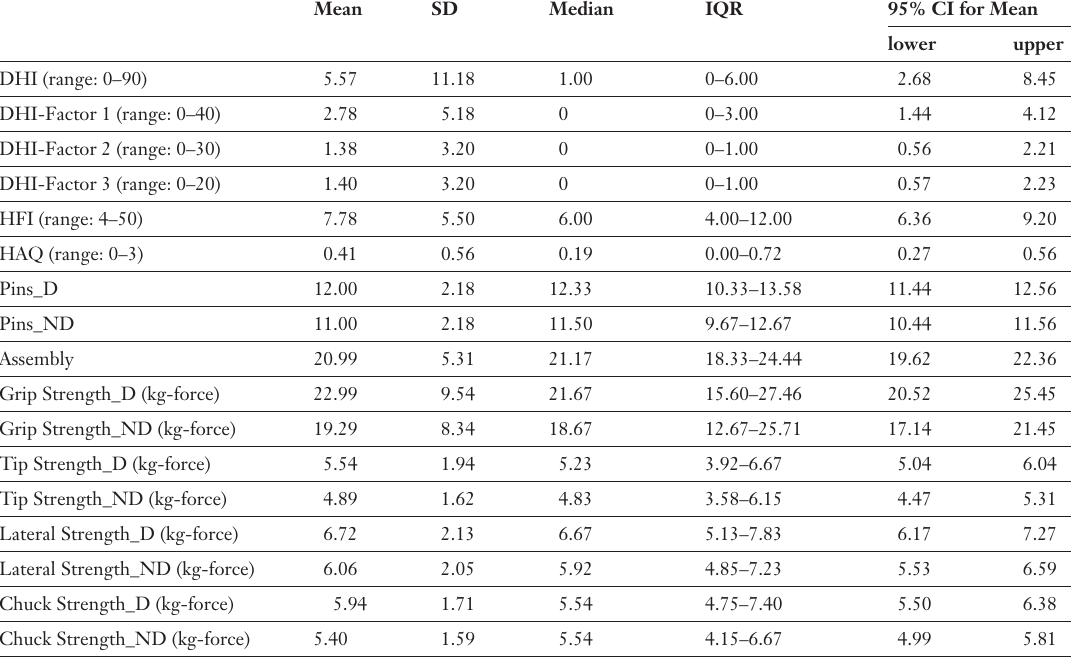
Functional characteristics’ of subjects (n =